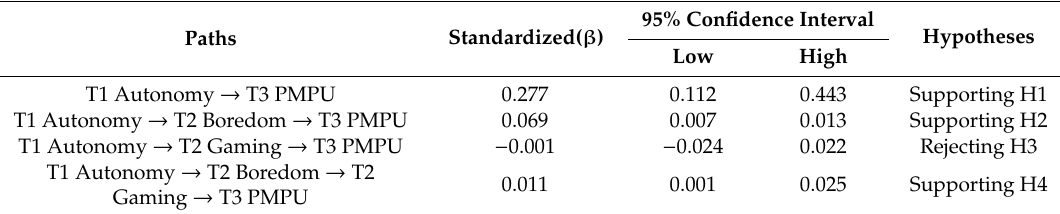
Table 2. Bias-corrected bootstrap tests on the direct and indirect effects.